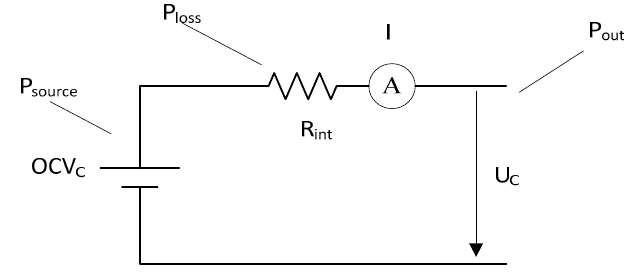
Figure 14. The R int model of battery cell or SC cell.